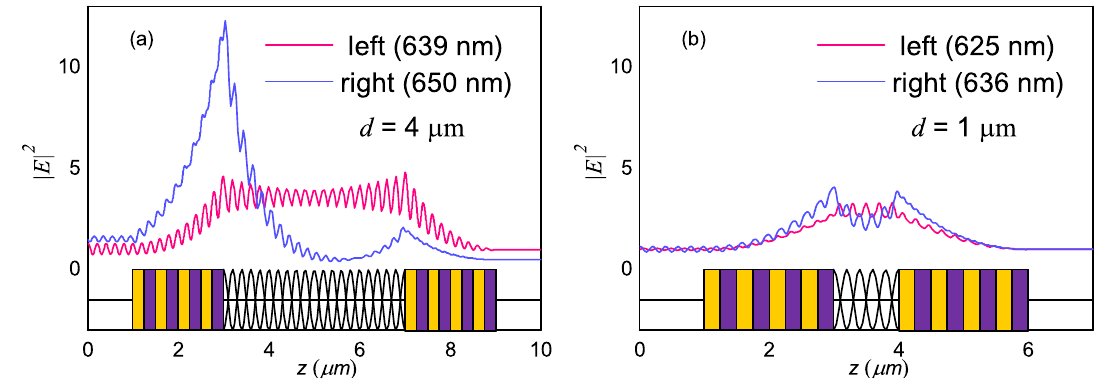
Figure 3. Spatial distribution of the local electric field intensity in the structure for the circular polarizations of incidence light. ( a ) d = 4 µ m and ( b ) d = 1 µ m. Each PPAM consists of 10 periods; ϕ = π /4.